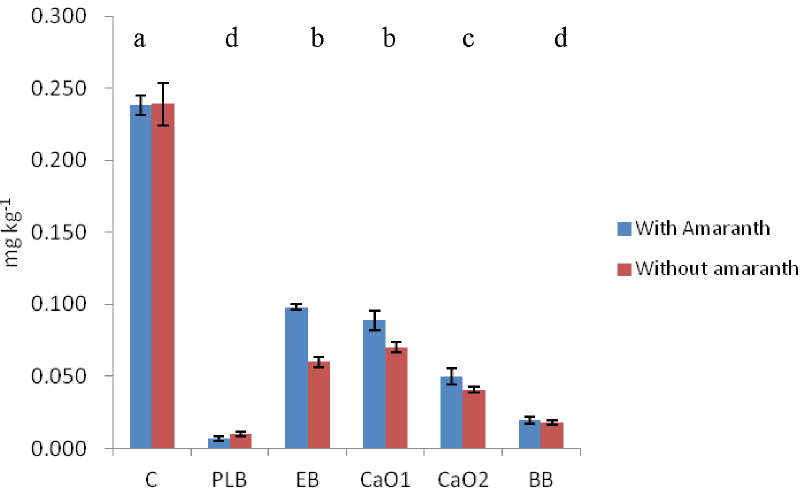
Figure 1. CaCl 2 extracted Cd for all the treatments at the end of the experiment. Different letters in the same indicate statistical significant differences for the factor ‘‘type of amendment’’ (P , 0.05).